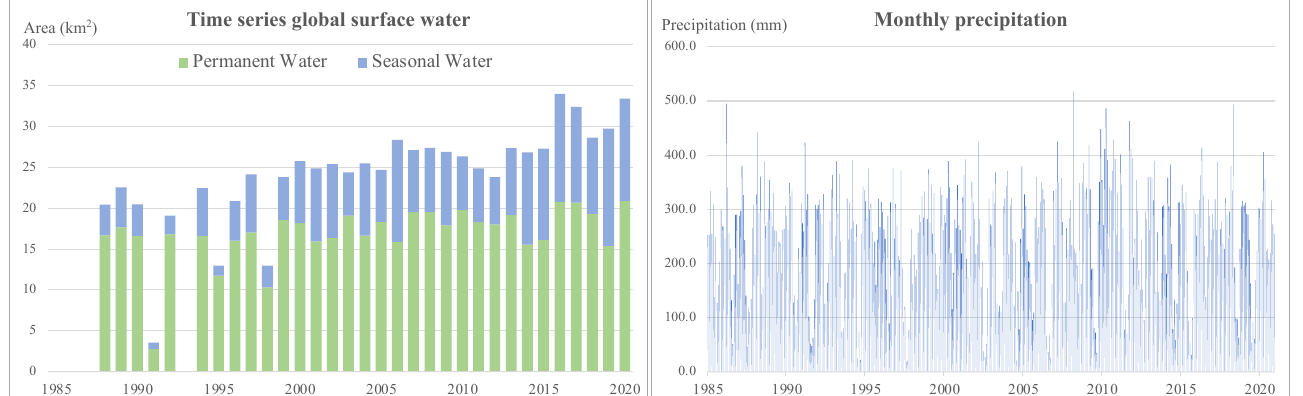
Figure 4. Trends of global surface water and monthly